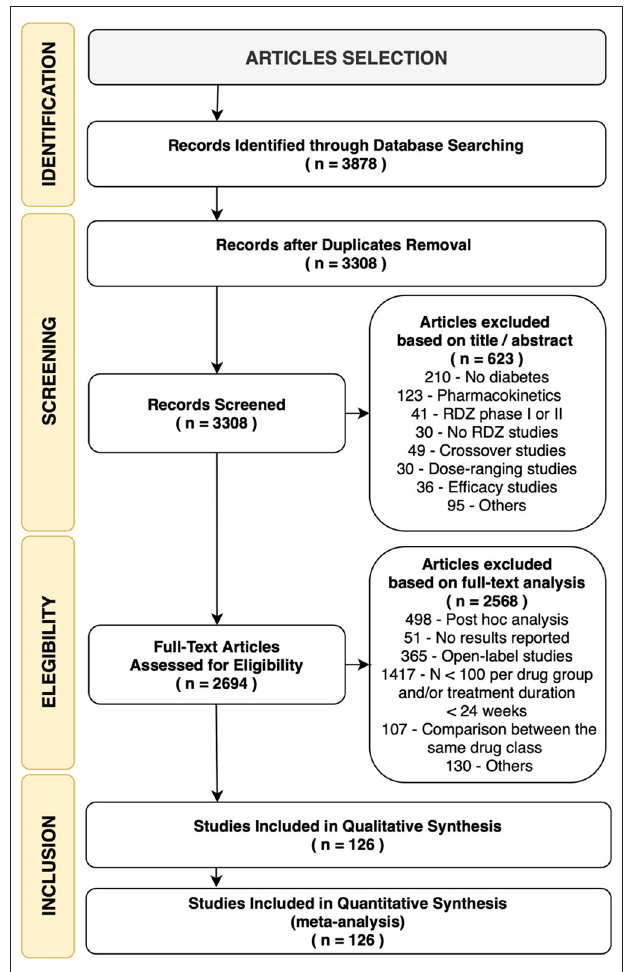
FIGURE 1 | Flow diagram of the trials’ selection process. RDZ,